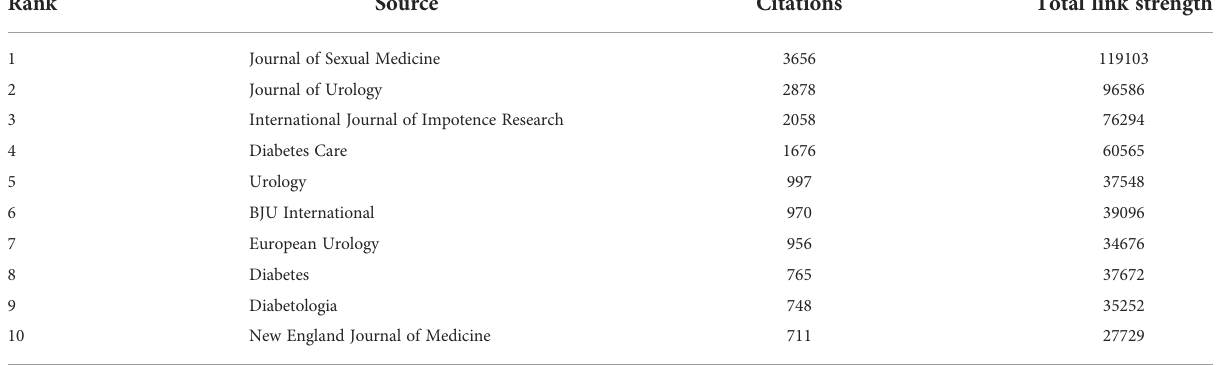
TABLE 8 The 10 most co-cited journals.